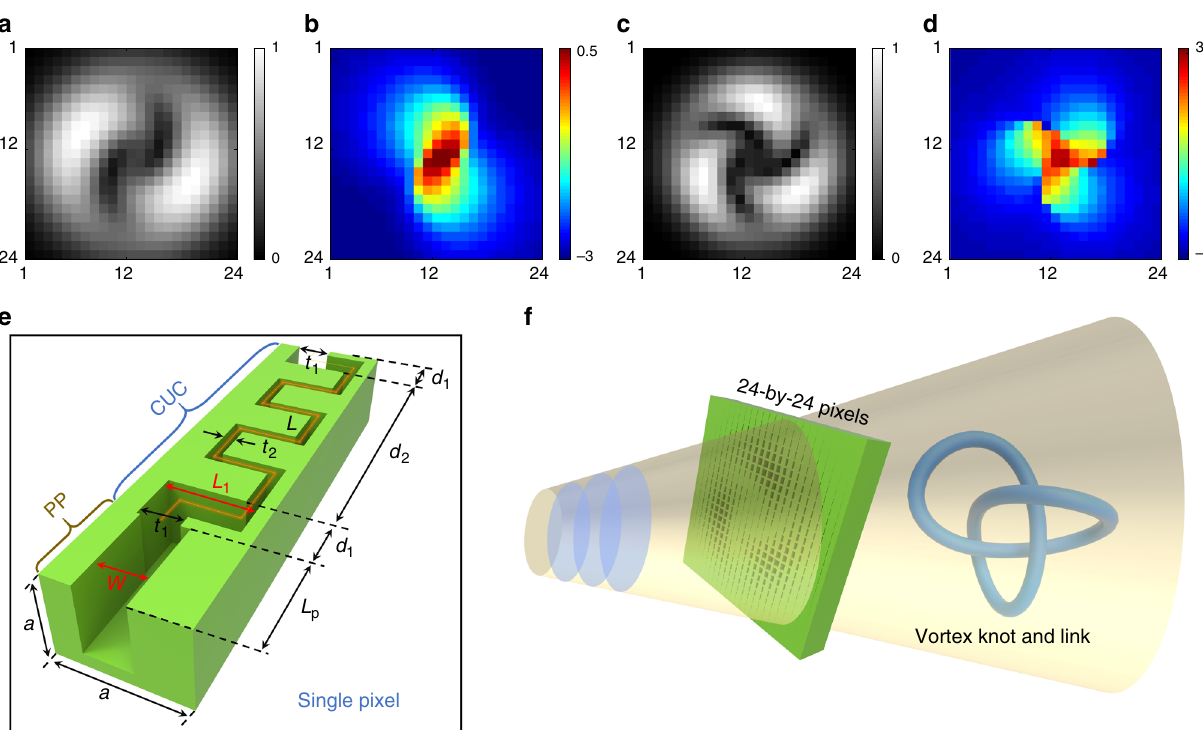
Fig. 1 The schematic of generating acoustic vortex knots with metamaterials. a , b plot the amplitude and phase distribution of the initial wavefront with 24-by-24 pixels to generate the Hopf link vortex line. c , d present the distribution of amplitude and phase on the initial wavefront with 24-by-24 pixels for the generation of the trefoil knot vortex line. e The structure of a single unit cell. The operation wavelength is λ 0 = 57.17 mm (6000 Hz). The width of the structure is a = λ 0 /3 = 19.07 mm. Here geometric parameters of CUC boundary layers are chosen as d 1 = 8.17 mm, t 1 = 6.17 mm, and L 1 = 13.3 mm. And geometric parameters of the CUC center layer are d 2 = 43.66 mm and t 2 = 2 mm. The relative phase shift of the transmitted fi eld can be tuned from 0 to 2 π with L (the orange line) changing from 2 to 16.05 mm. The length of PP is L p = λ 0 /4 = 28.585mm. The width of PP is W . f The schematic of creating acoustic vortex knots by using 2D metamaterial-based hologram with both phase and amplitude